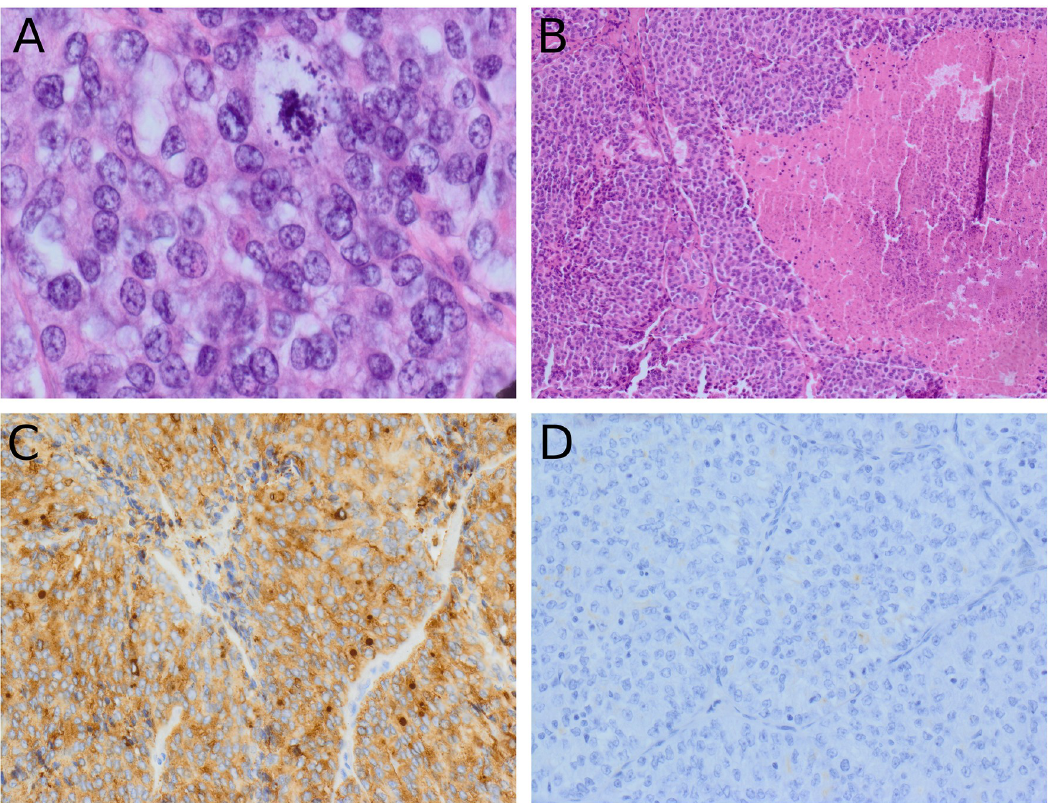
Fig 2. Histological findings (H&E stain) in poorly differentiated thyroid cancer. (A) Atypical mitosis in a tumor with a predominant insular pattern of growth ( × 400), and (B) extensive necrosis ( × 200). Thyroglobulin immunohistochemistry: (C) positive and (D) negative.